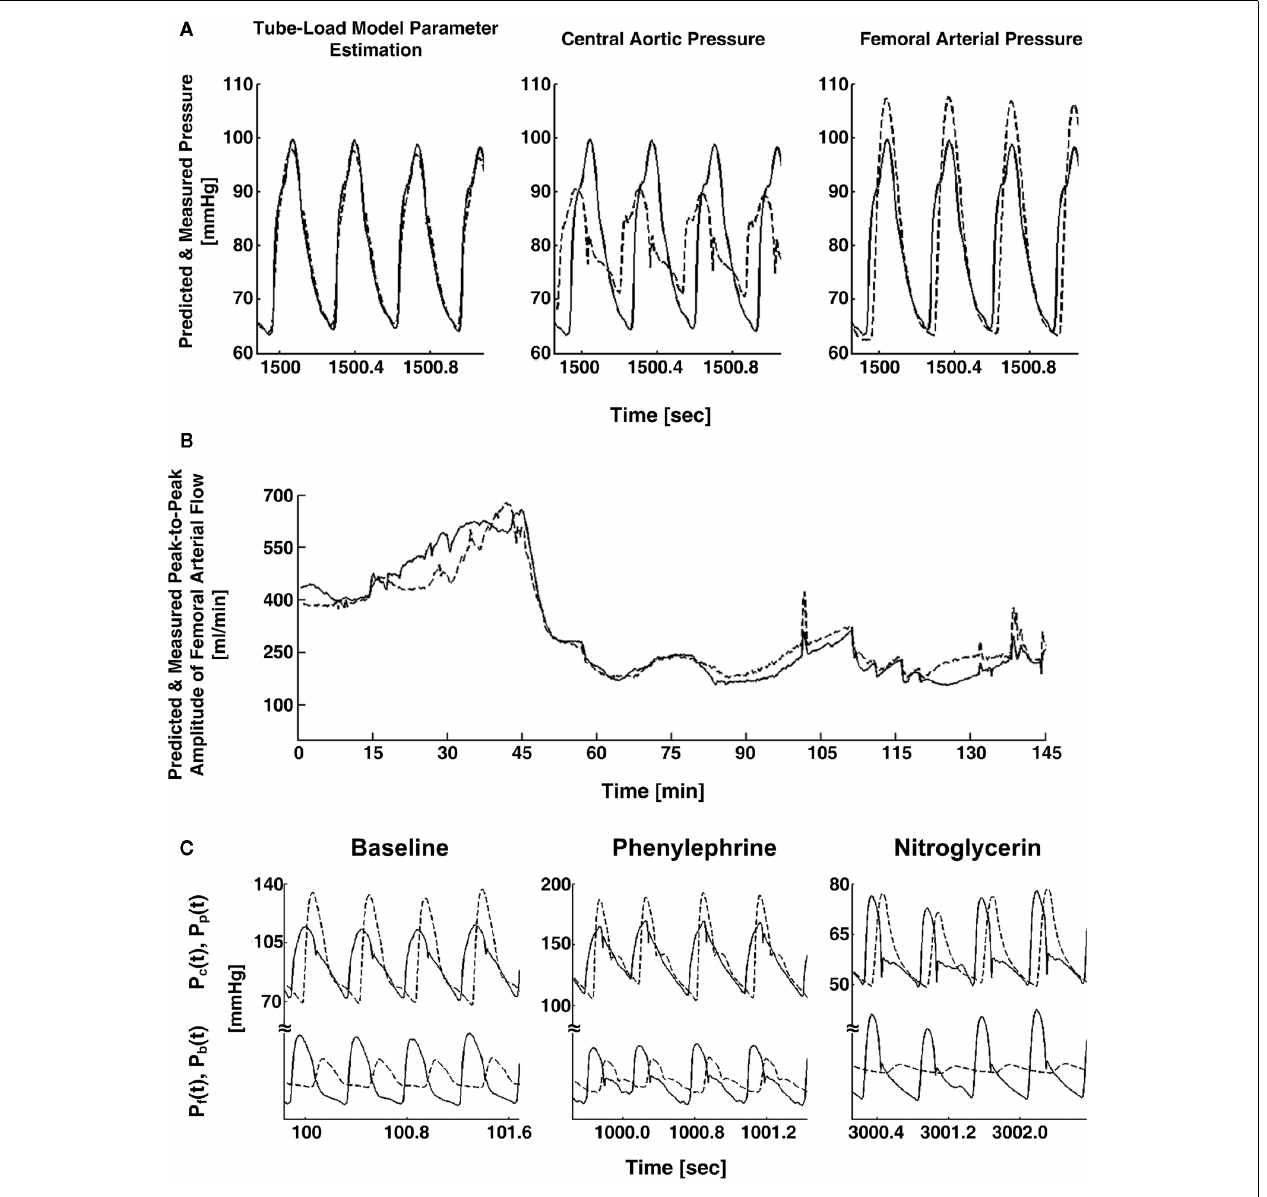
pressure waveforms during several interventions. (C) Measured central aortic [ P c ( t ), solid] and femoral arterial [ P p ( t ), dash] pressure waveforms (upper) and forward [ P f ( t ), solid] and backward [ P b ( t ), dash] waves in the central aorta (lower) calculated from the measured waveforms. Adapted from Swamy et al.